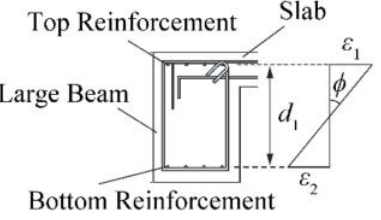
Figure 15. Curvature considering strain in the